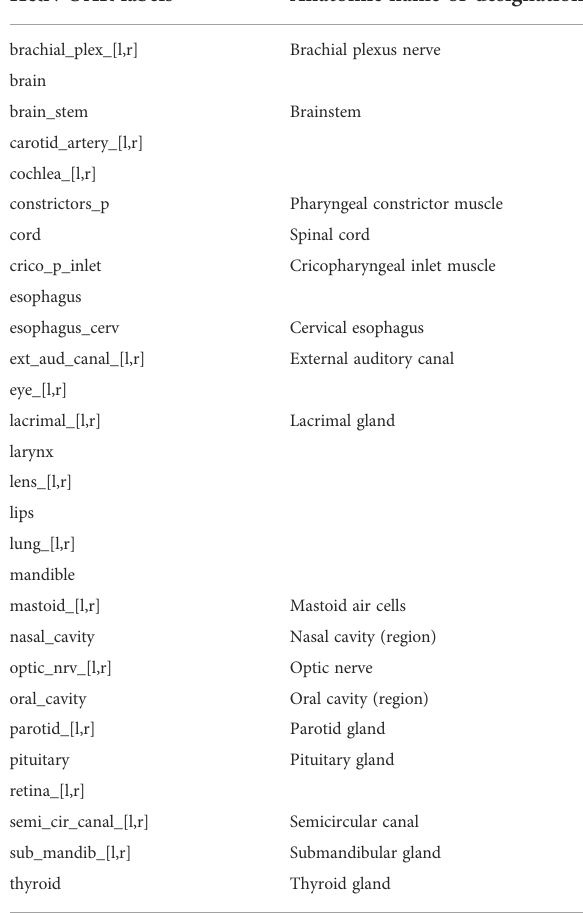
TABLE 3 H&N OAR segmentation labels and their anatomic